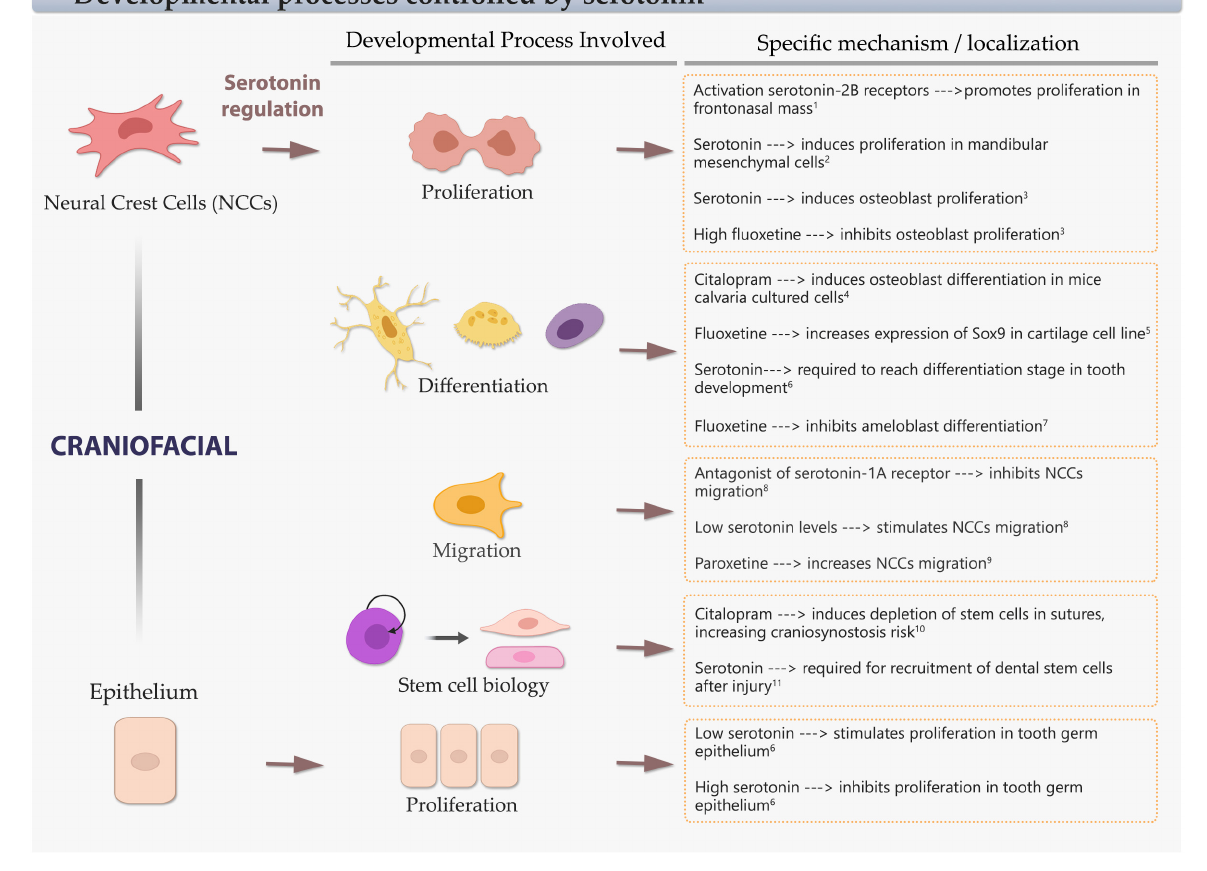
Frontiers in Cell and Developmental Biology |